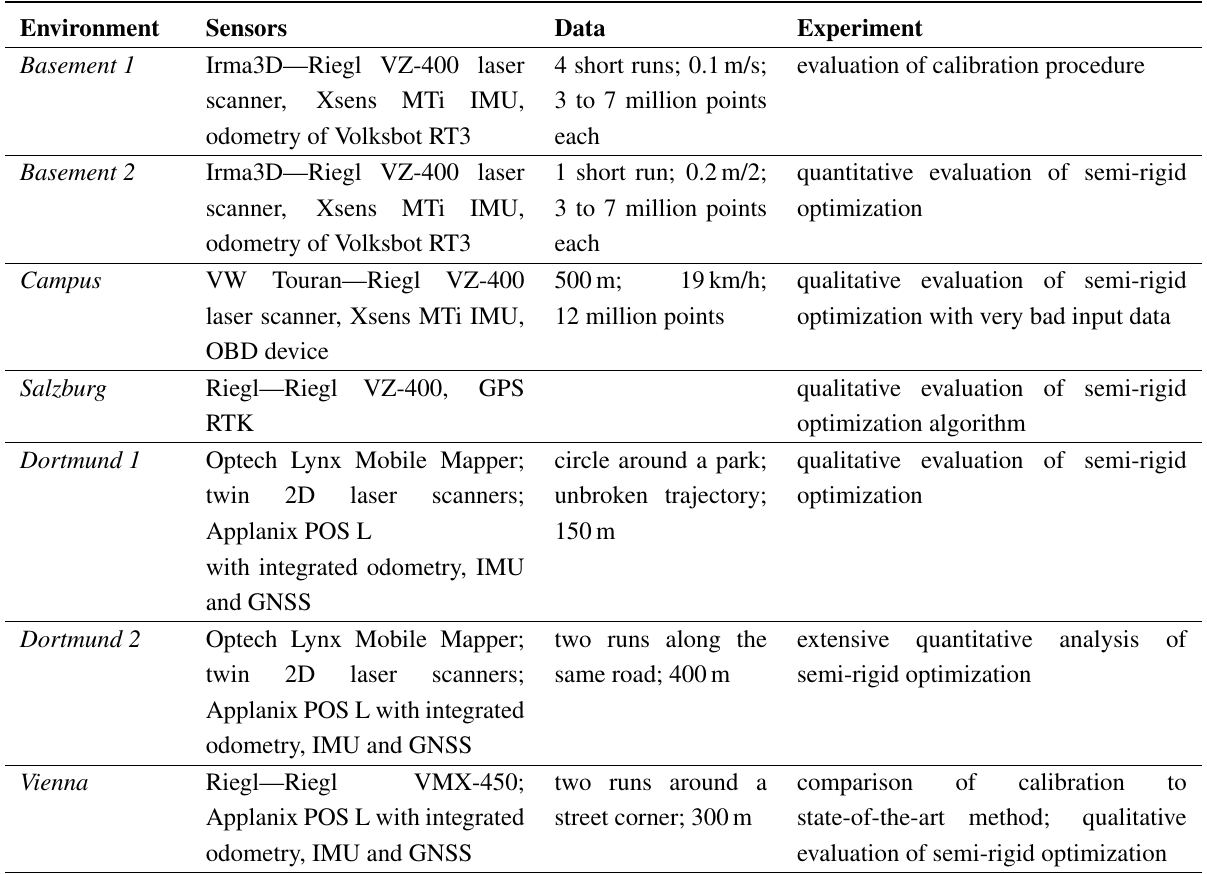
Table 1. Overview of datasets used in the experiments. OBD, on-board diagnosis; IMU, inertial measurement unit; GNSS, Global Navigation Satellite